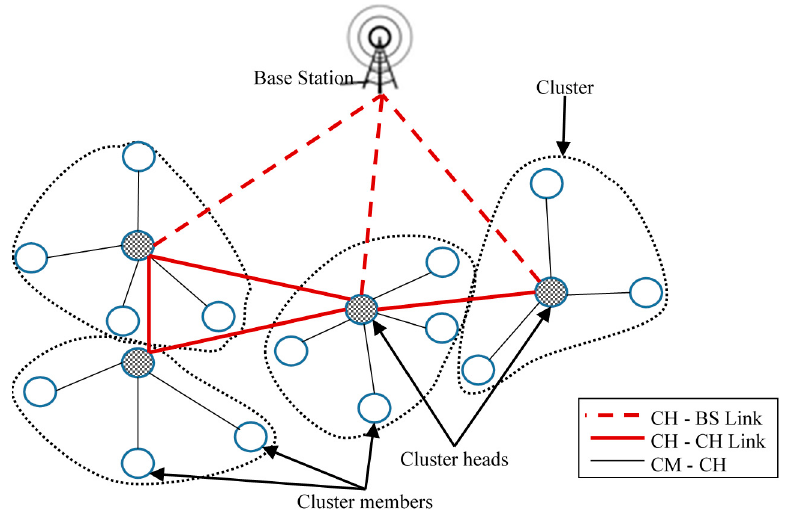
Figure 1. Conventional typical WSN cluster structure.